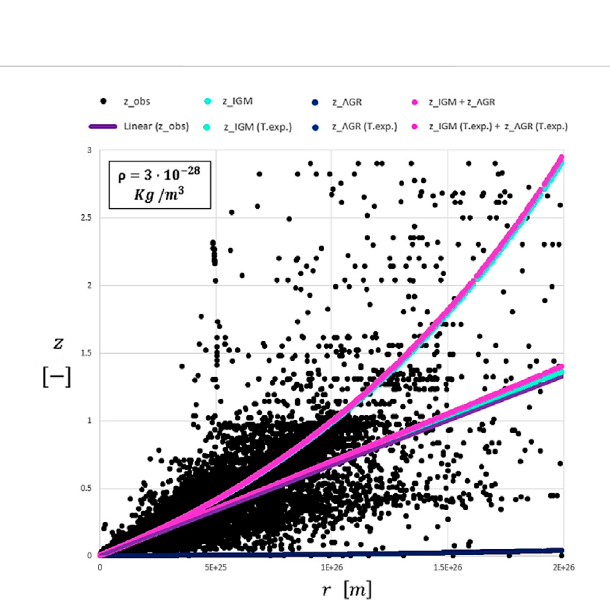
FIGURE 7 Plot of Figure 6 with a smaller average mass density of visible